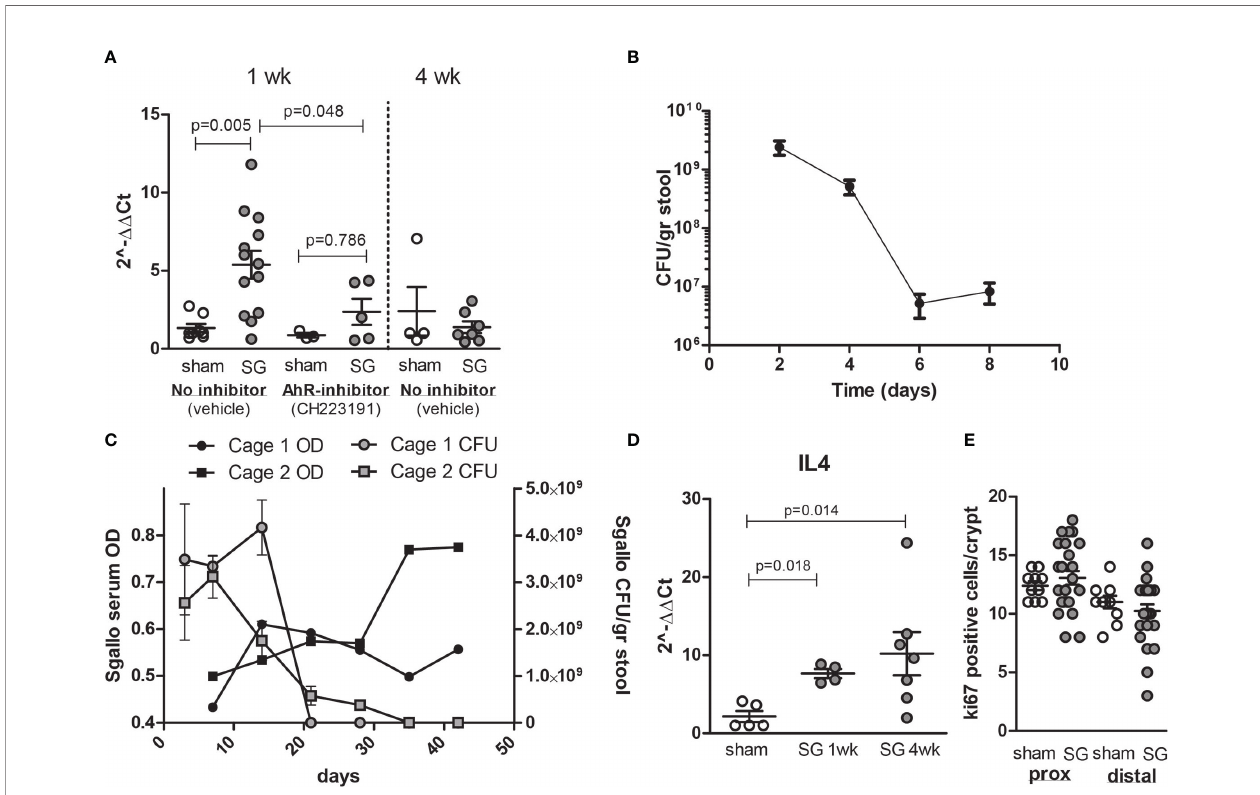
FIGURE 6 | Colonization of C57bl6 mice leads to CYP1A1 induction in cecum and effective clearance of S. gallolyticus . (A) Compared to sham mice (n = 8), S. galloltyicus UCN34 colonized mice show signi fi cantly increased levels of CYP1A1 at 1 week postcolonization (n = 13, Mann – Whitney U-test p = 0.005) that is not observed in mice treated with daily gavage of the AhR-inhibitor CH223191 (n = 5). At 4 weeks postcolonization, CYP1A1 induction is back to normal levels (n = 7). (B) Stool colonization of UCN34 monitored at 2 (n = 4), 4 (n = 8), 6 (n = 9), and 8 days (n = 14) postcolonization. Two out of fi ve AhR-treated animals lost colonization by day 8, whereas 3 out of 13 vehicle-treated-mice lost colonization. The colonization levels at days 6 – 8 were not signi fi cantly different for vehicle or AhR-treated animals (Mann – Whitney U-test, p = 0.12, Supplementary Figure S6 ). (C) Colonization of S. galloltyicus UCN34 over time up to 42 days (6 weeks) with weekly serum collections (without vehicle or AhR-inhibitor) (n = 8). CFU of S. galloltyicus in gray circles (cage 1; n = 4) and squares (cage 2;n = 4) decreased after 3 weeks signi fi cantly, while antibody production starts to increase at 2 – 3 weeks postcolonization (black circles and squares). Cages were visualized separately because of differences in colonization and antibody responses between the two cages. The treatment, inoculation, and handling of the animals in these two cages was similar. (D) IL4 mRNA production is increased at 1 and 4 weeks post-UCN34 colonization compared to sham mice (Mann – Whitney U-test p = 0.018 and 0.014, respectively). (E) ki67 stained slides were scored for total number of positive ki67 cells per crypt; for each mice, fi ve crypts were counted and plotted. No difference in ki67-positive cells was seen in proximal and distal colon at 1 week postcolonization compared to